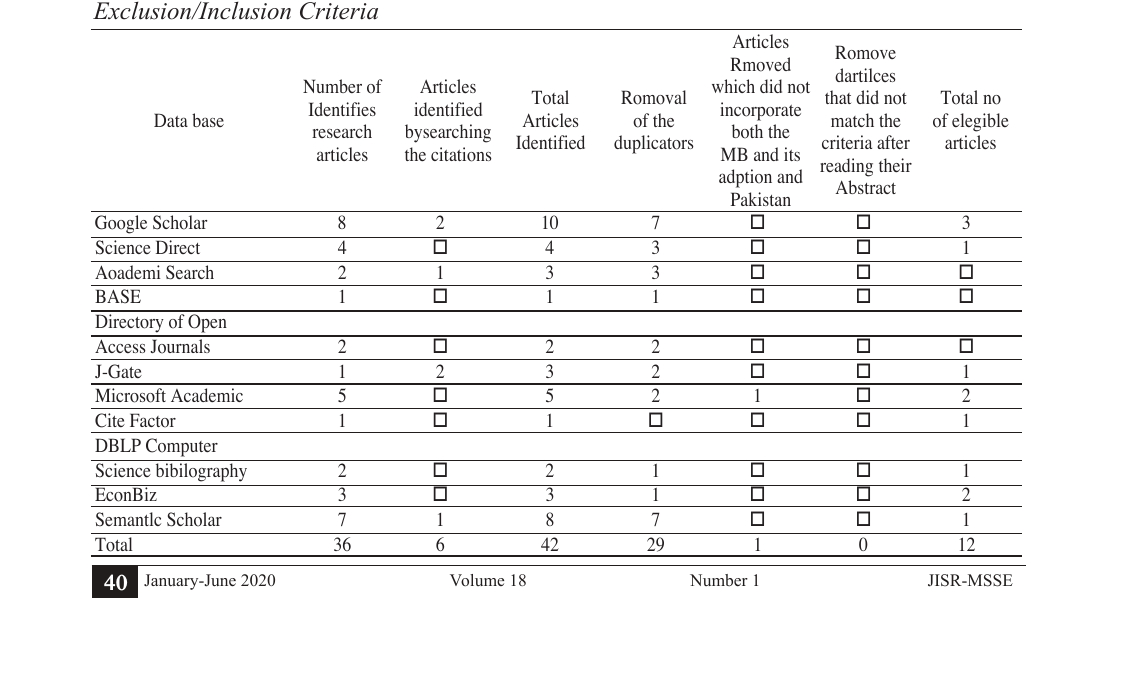
Total no of elegible